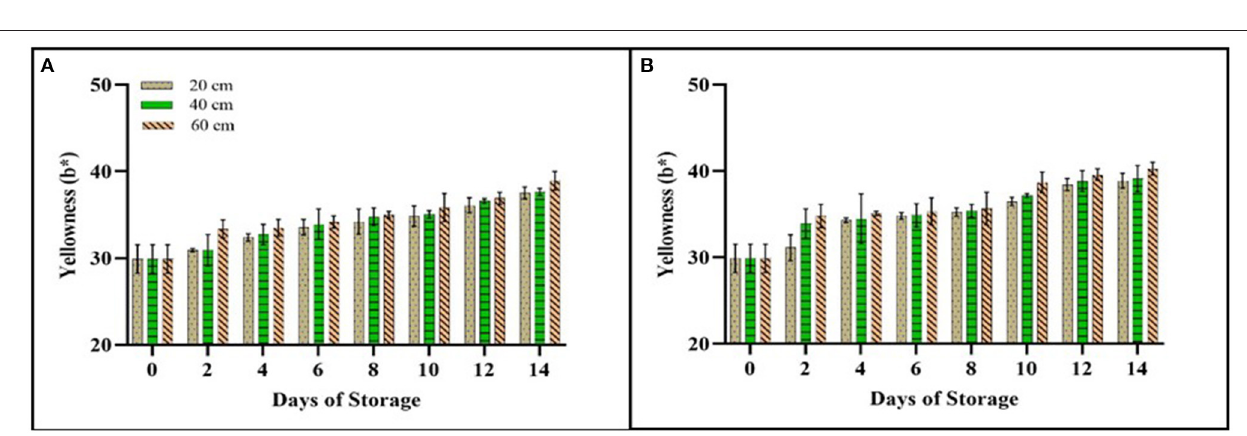
the increase on BS ( R 2 20cm,10 ◦ C : 0.9034, R 2 40cm,10 ◦ C : 0.9173, R 2 60cm,10 ◦ C : 0.8795, R 60cm,22 ◦ C : 0.9105) ( Figure 8